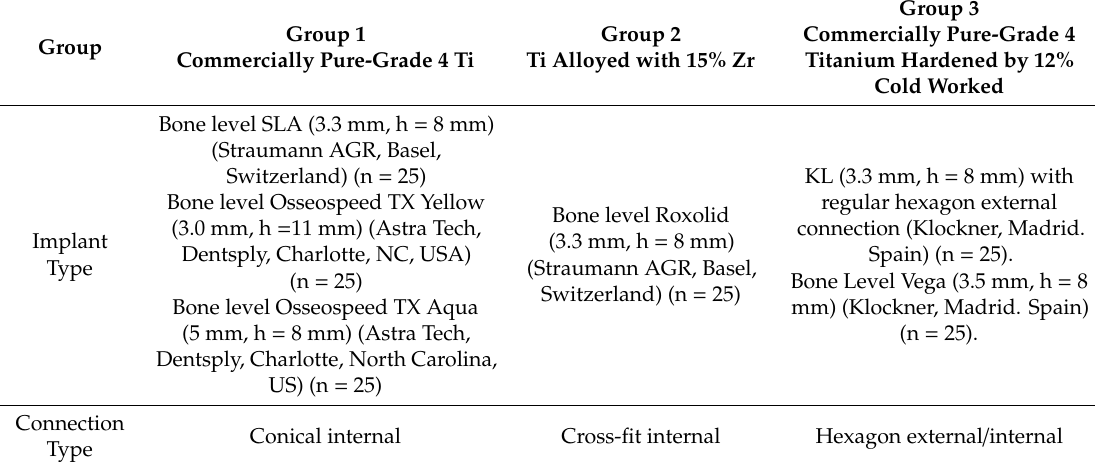
Table 1. Implants used distributed by group